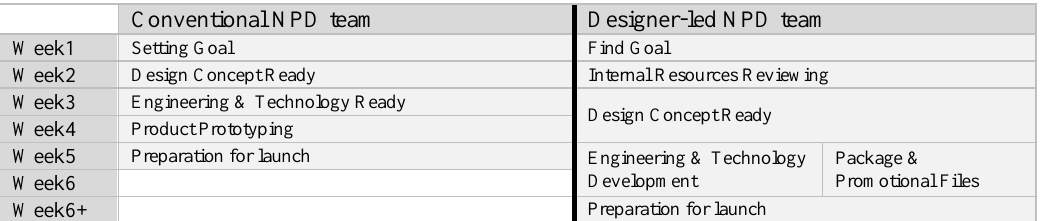
Table 5 : Timetable of Two NPD